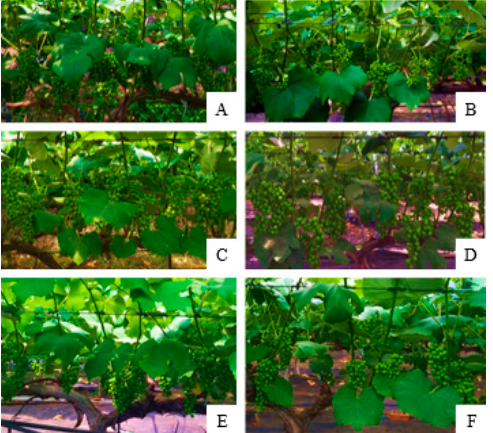
Figure 22. Development status of grape granules according to solar-module installation. ( A ) Normal control site, ( B ) normal solar-panel site, ( C ) bifacial control site, ( D ) bifacial solar-panel site, ( E ) transparent control site, and ( F ) transparent solar-panel site.